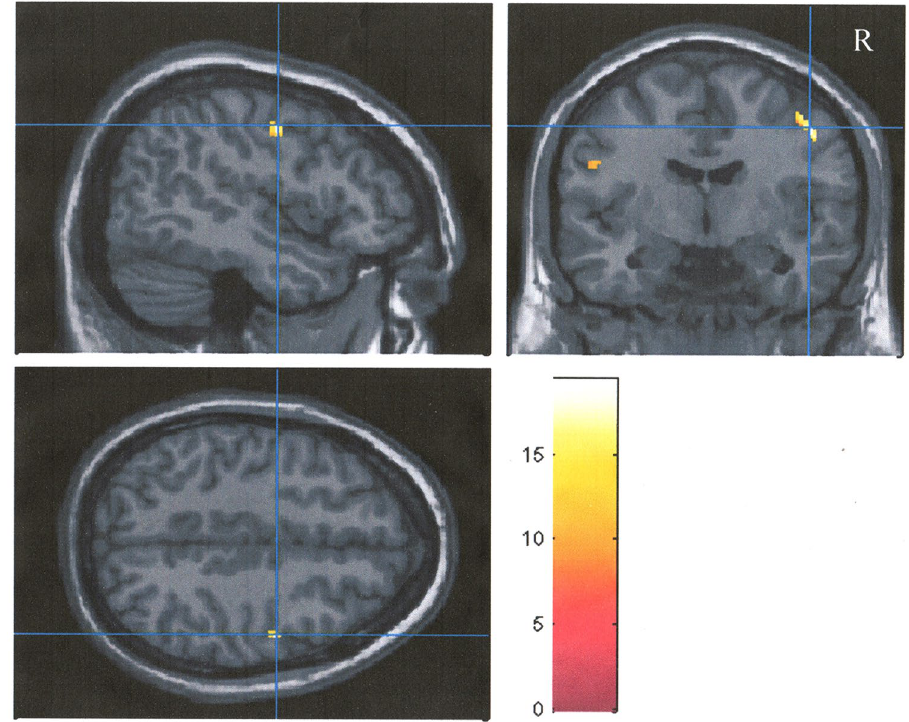
Figure 3. Findings showing clusters of changes in cerebral metabolic glucose rate (CMRgl) in the frontal lobe of the right hemisphere highlighted in yellow in exercise-trained and control patients with obstructive sleep apnea. Foci of significance are overlaid on sagittal, coronal, and axial brain slices spatially normalized in MNI space. All voxel clusters shown in the figures retained statistical significance after family-wise error correction for multiple comparisons ( P < 0.005), corrected for multiple comparison over right frontal lobe and had a minimum extent threshold of 20 voxels. Statistical details are given in Table 4. The colored bar represents F-values. The model includes APOE ε4 allele and time interval between magnetic resonance data collection as covariates. R = right.